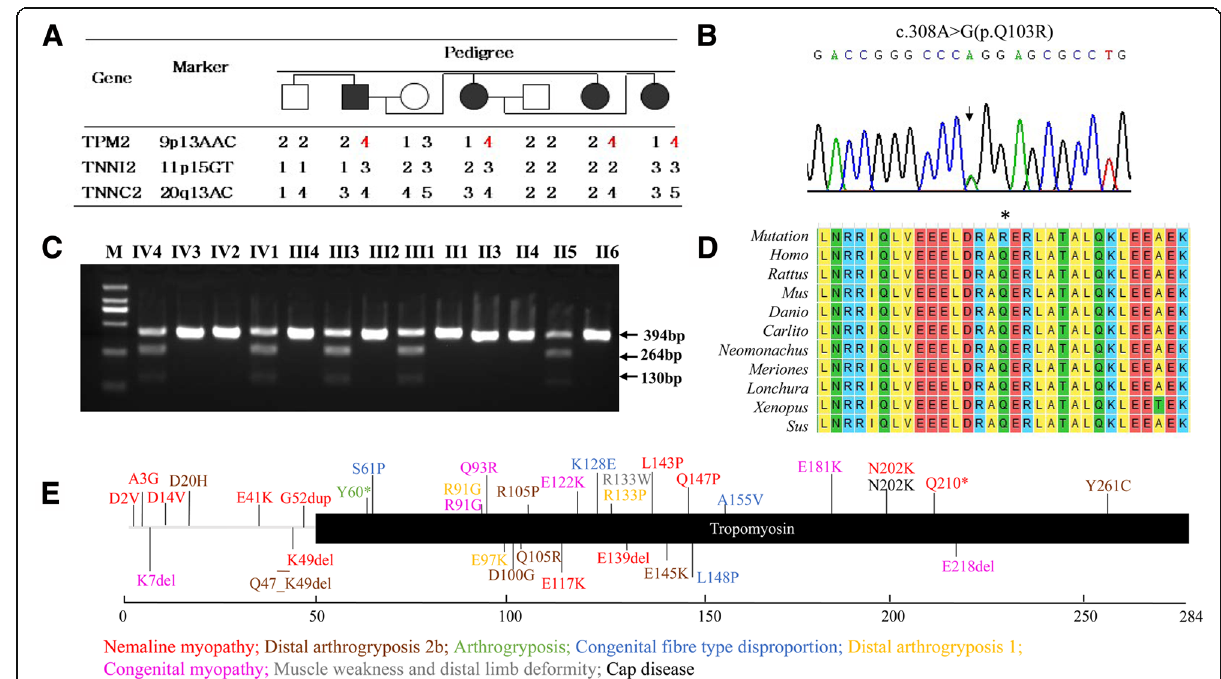
Fig. 3 Identification of a missense mutation in TPM2 in Family 1. a Genetic linkage analysis was carried out with 3 microsatellites, and TPM2 was identified as the candidate gene. b Sequencing results indicate the heterozygous mutation c.308A > G in exon 3 of TPM2 . c DNA fragments from the affected individuals (II5, III1, III3, IV1, and IV4). Three fragments were separated by electrophoresis (394 bp, 264 bp, and 130 bp). d Multiple- species sequence alignment shows the evolutionary conservation of position p.Q103 in TPM2. e The schematic of TPM2 mutation spectrum on functional module. Mutation-related diseases are exhibited in different literal